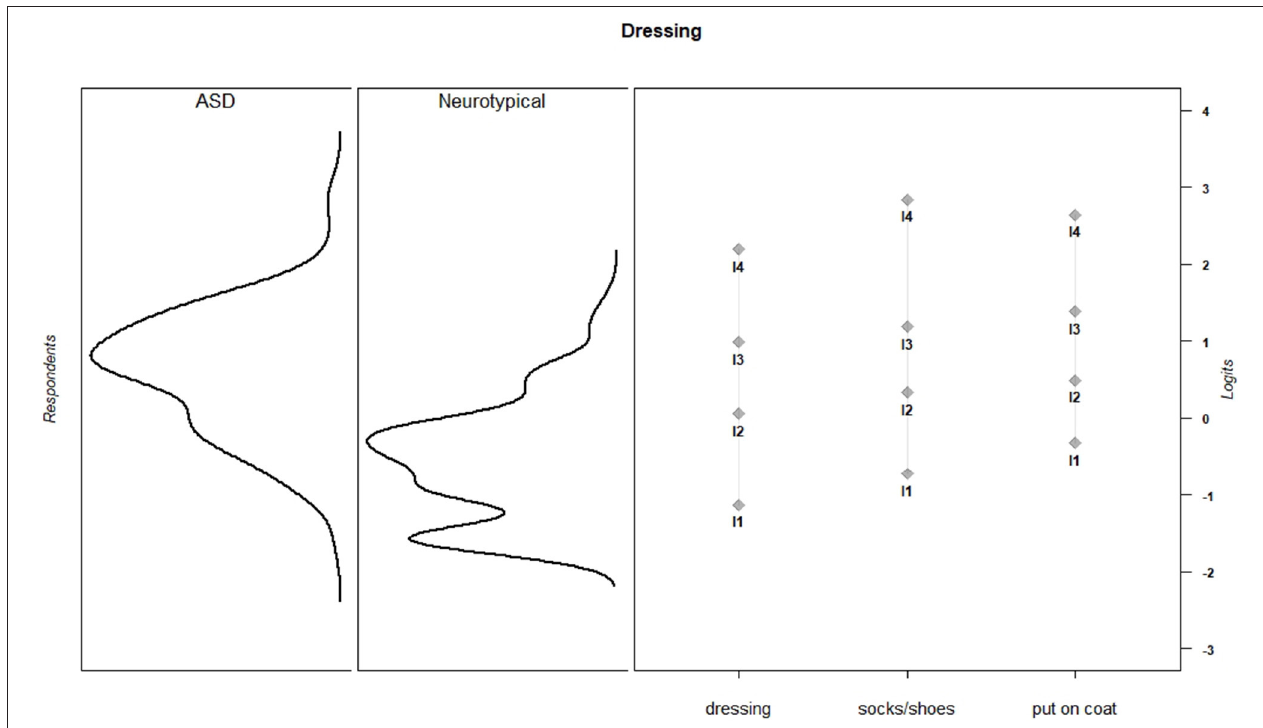
FIGURE 1 | Dressing item parameters and person parameters by subgroup.